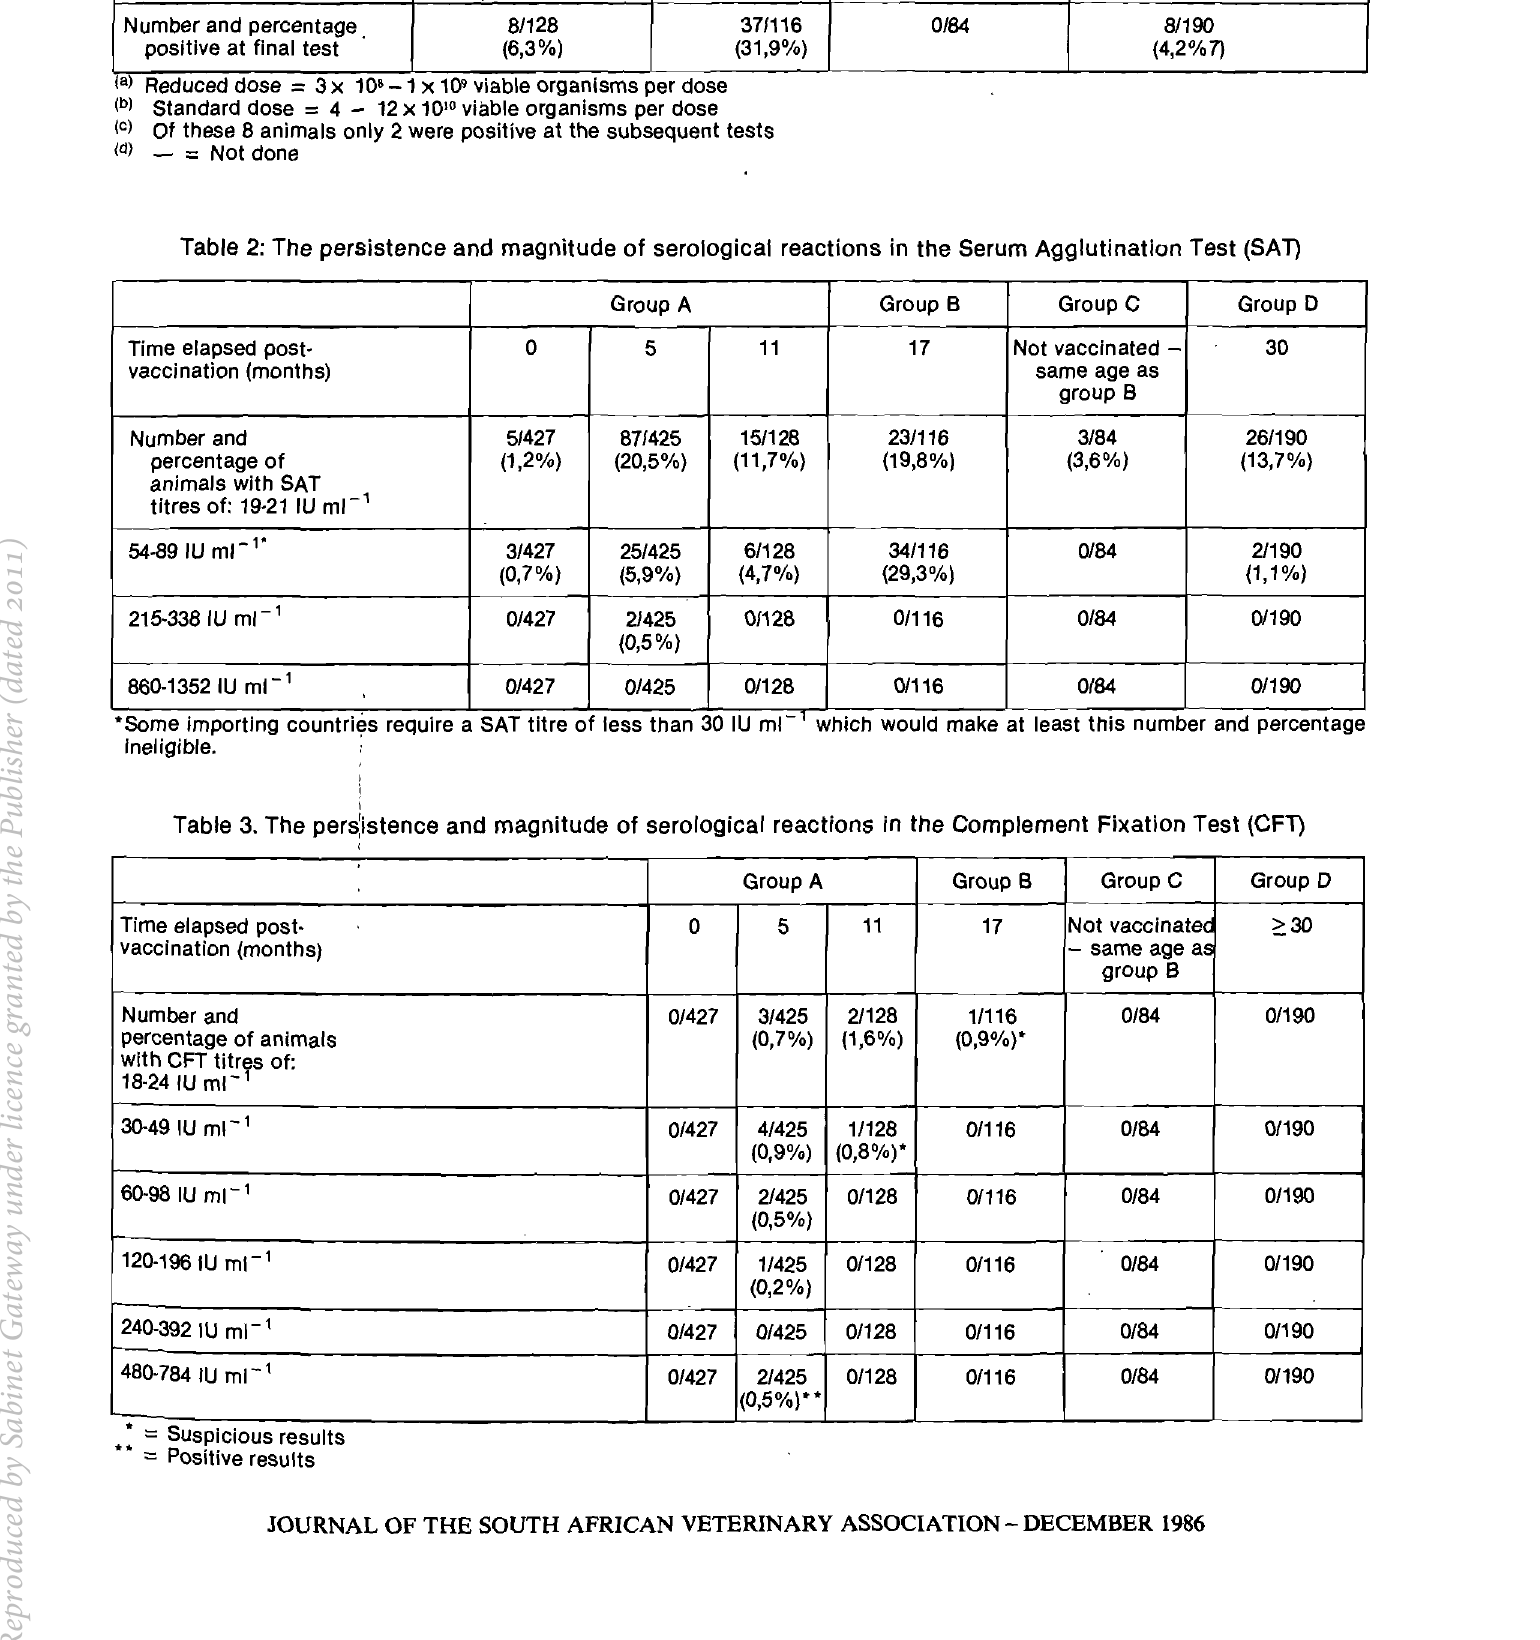
Number and percentage.